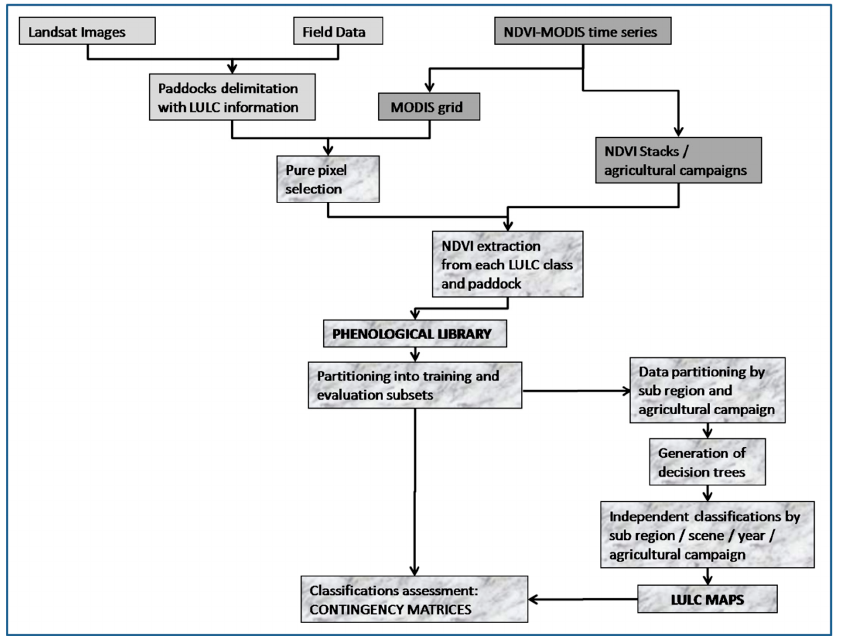
Figure 2. Data used and steps taken to generate and evaluate Land Use/Land